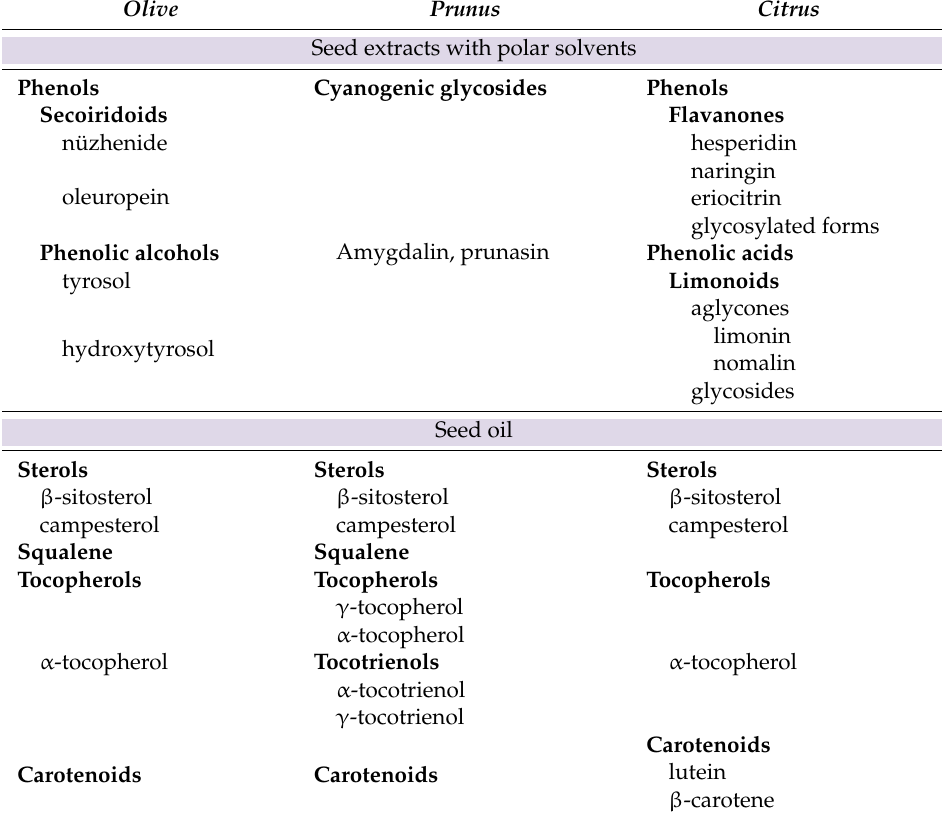
Table 1. Key bioactive ingredients found currently in hydrophilic and lipophilic fractions of the seeds of olives, prunus and citrus